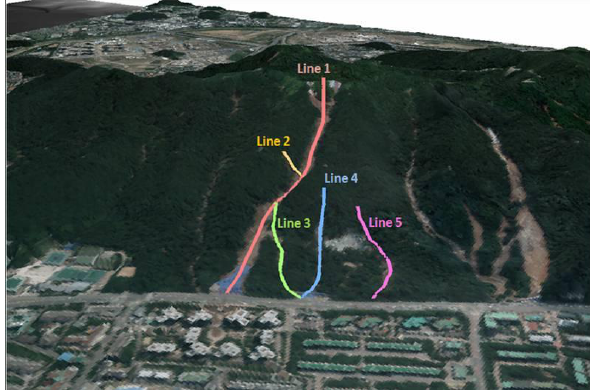
Figure 7. 3D schema of the flow path before and after the event